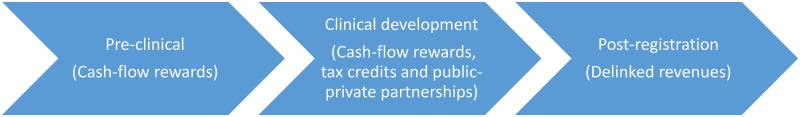
R&D incentives over the antibiotic lifecycle.